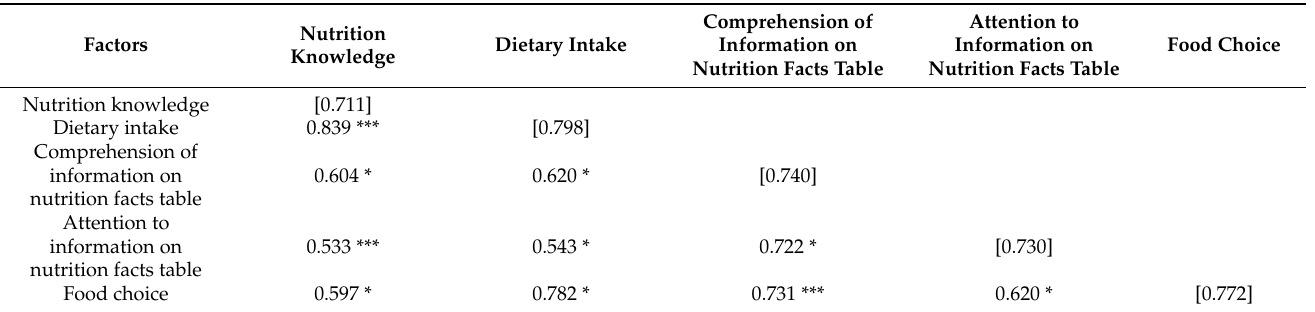
Table 4. Factor correlations and discriminant validity.